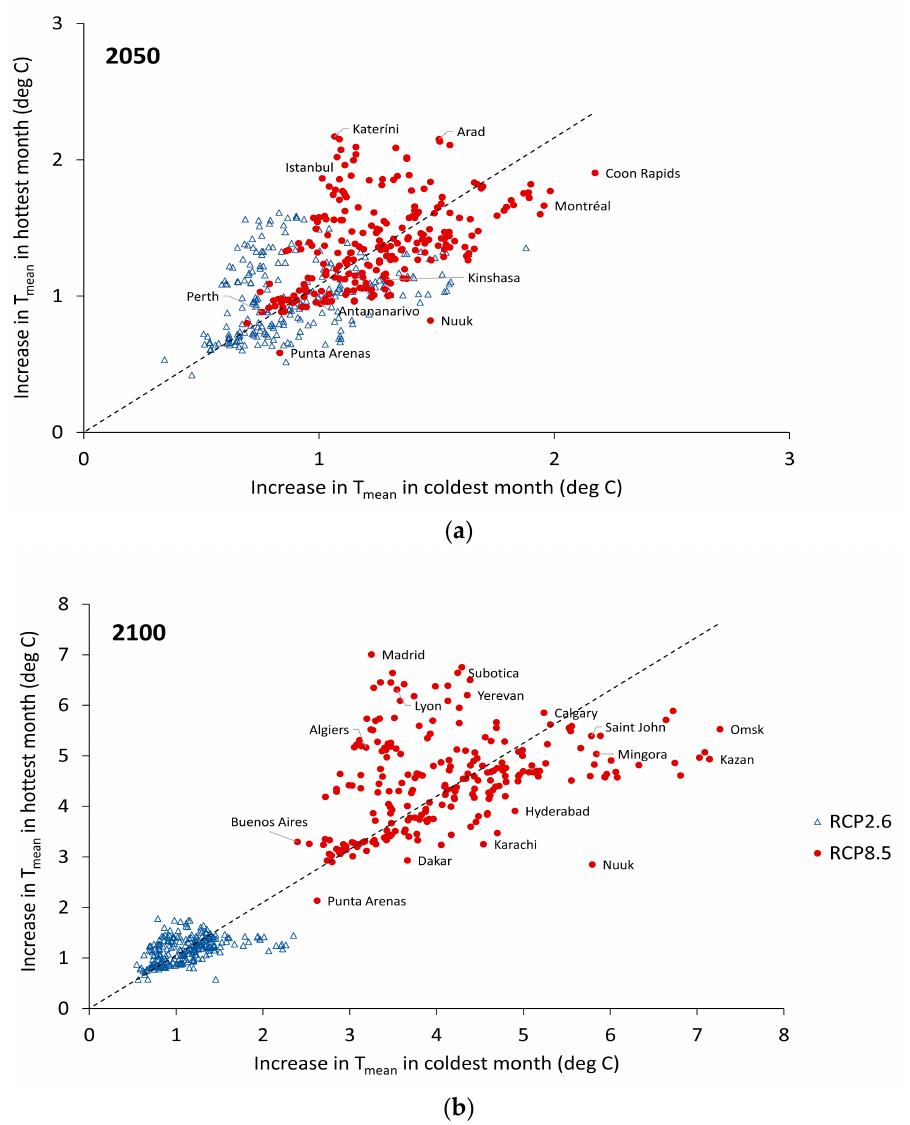
Figure 2. Increase in T mean in the hottest month vs. in the coldest month (relative to 2017) under RCP2.6 (blue open triangles) and RCP8.5 (red dots) by: ( a ) the year 2050 and ( b ) the year 2100.